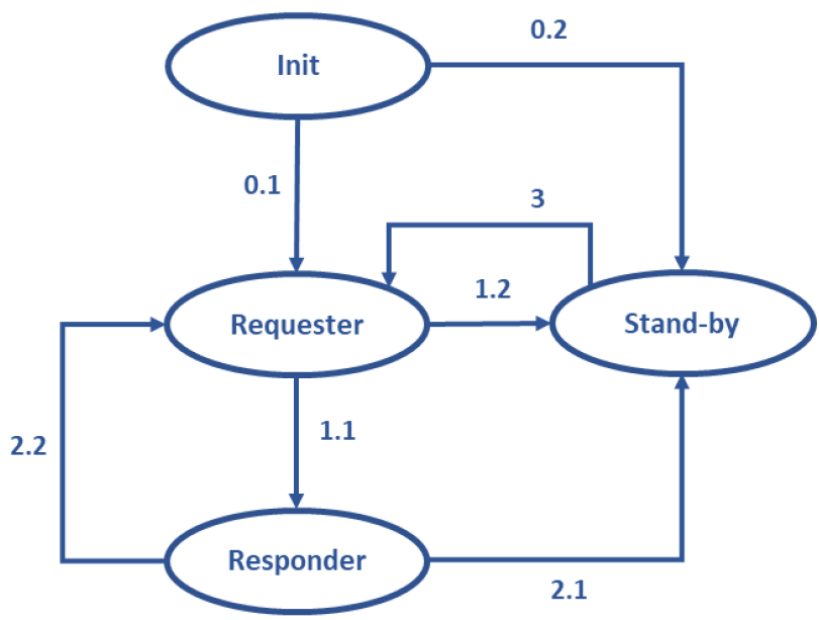
Figure 4. States of each prosumer.